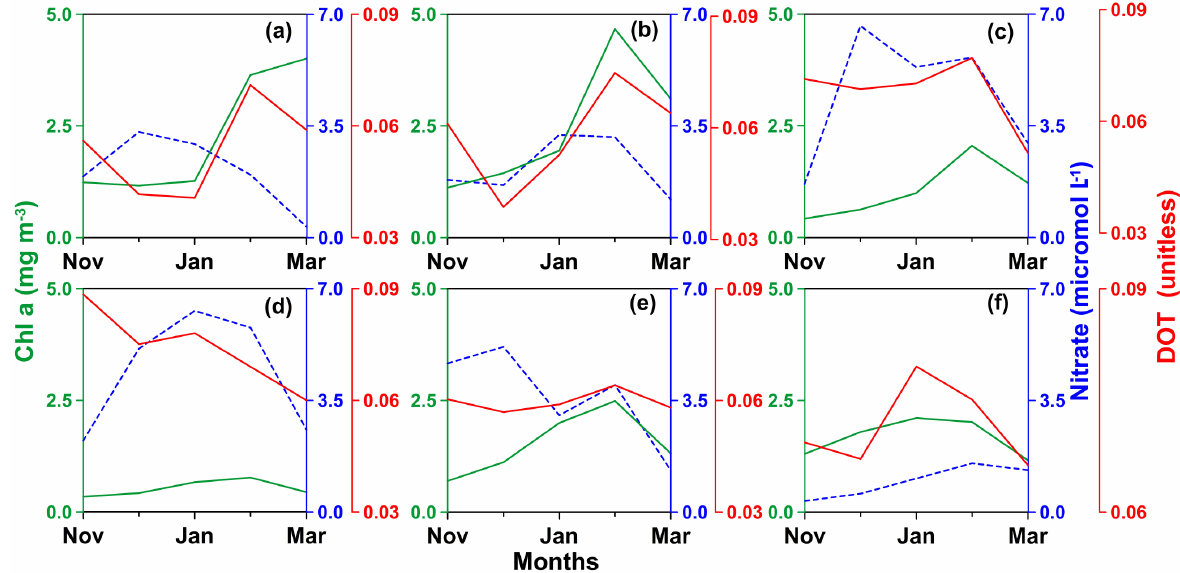
Figure 9. Averaged variability of surface Chl a , nitrate and DOT in six ecological zones. Panels (a) – (f) represent variability along the first to sixth zones,